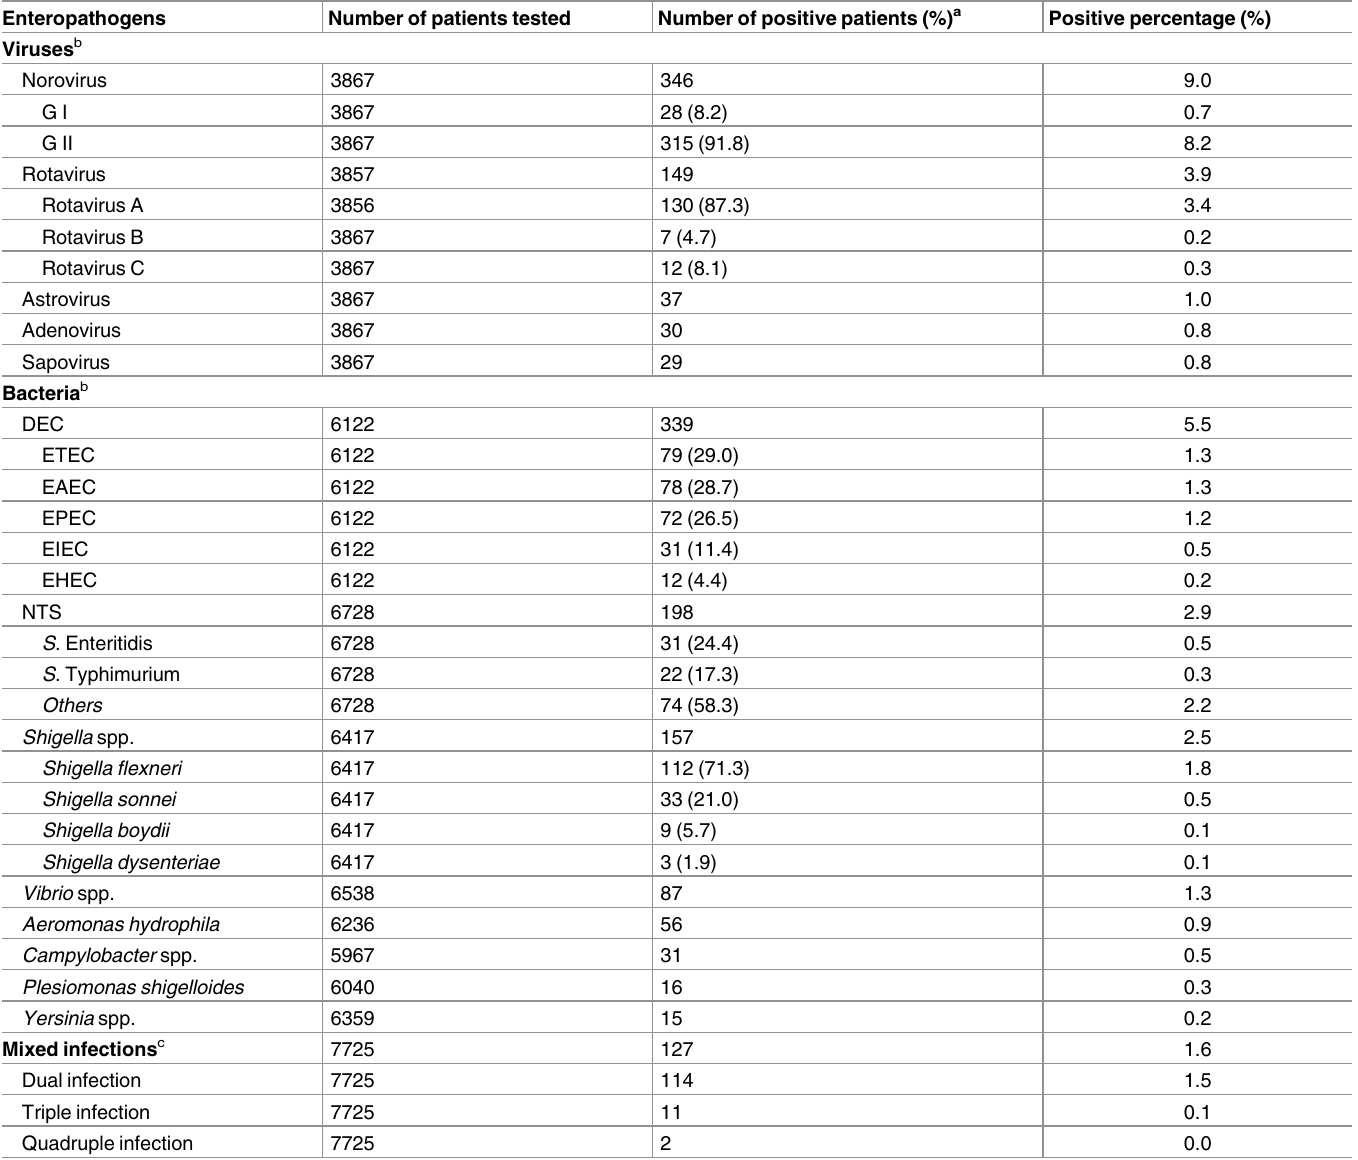
Table 2. Enteropathogens in the elderly outpatients ( (cid:21) 65 years)with acute diarrhea in China,